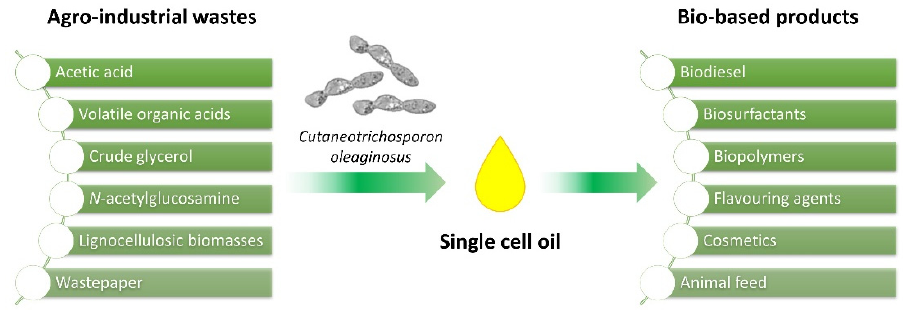
Figure 1. Schematic representation of the main substrates and products covered in the